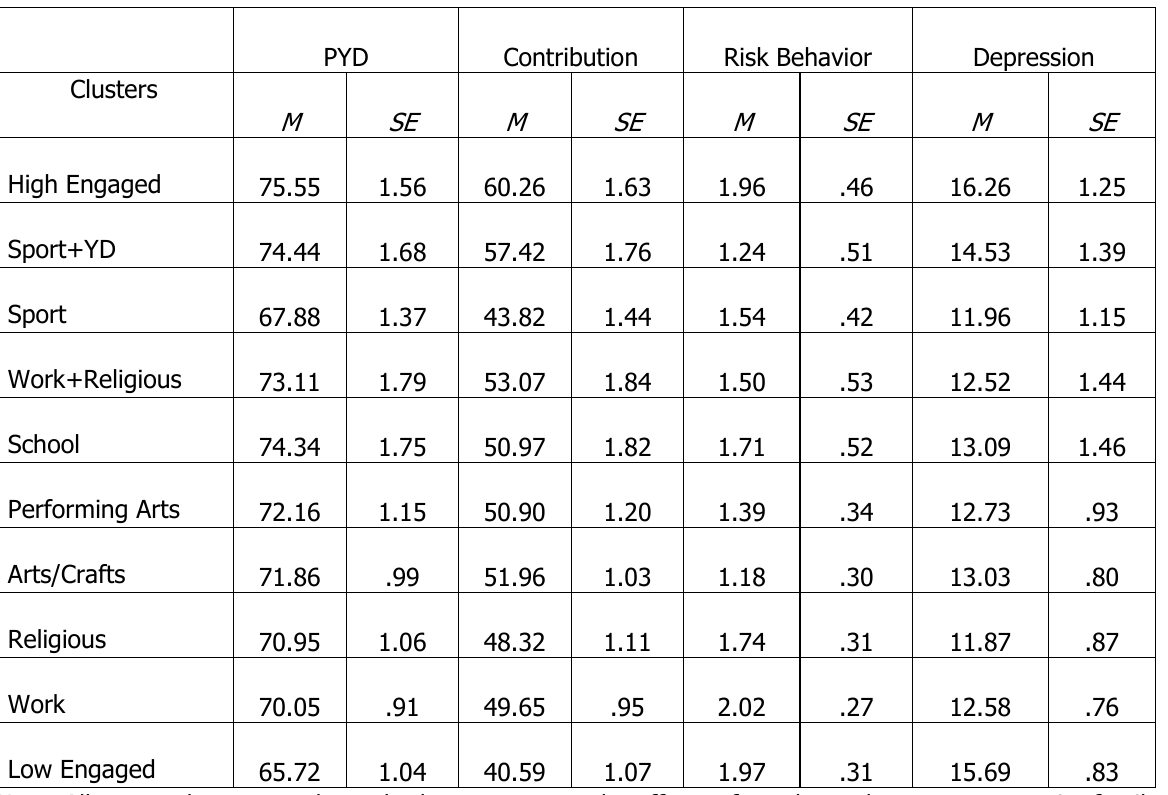
Means and Standard Deviations of Indicators of PYD by Grade 7 Activity Participation Profiles